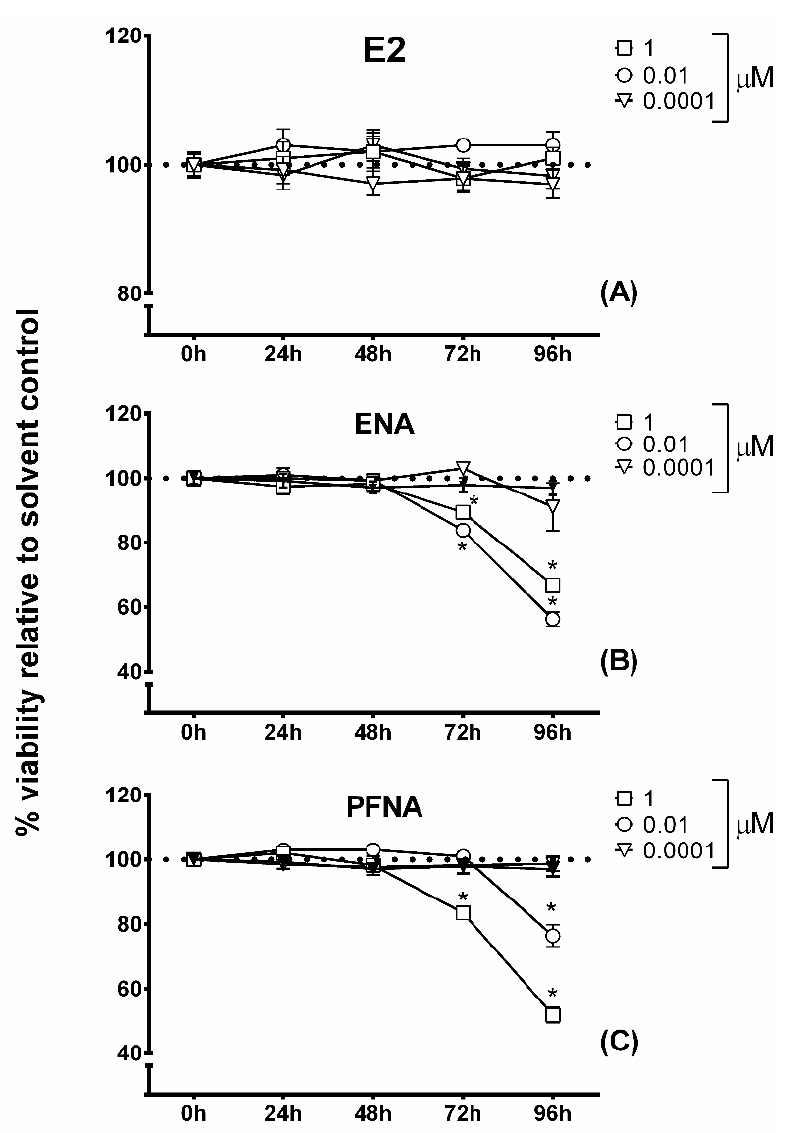
Figure 2. MTT assay of Mugil cephalus hepatocytes following exposure to E2 ( A ), ENA ( B ), PFNA ( C ) for up to 96 h. The dot line represents cell viability measured in the solvent control (assigned a survival of 100%). Values are given as mean ± SEM of three independent experiments in % relative to the solvent control. “*” indicates significant differences between control and treated groups ( p < 0.05). We further discuss the mRNA expression of VTG at the level of protein concentrations in the medium used for the primary cultures of grey mullet hepatocytes. At 48 h after treatment, E2 caused a significant dose-dependent increase in VTG synthesis at any of the tested concentrations relative to control cultures (Figure 4). Both PFNA and ENA also increased the VTG synthesis, but to a lesser extent. Indeed, a significant increase in VTG levels occurred following treatment with the highest doses (0.01 and 1 µ M) of PFNA. In contrast, VTG up-regulation was only induced in response to exposure at 1 µ M